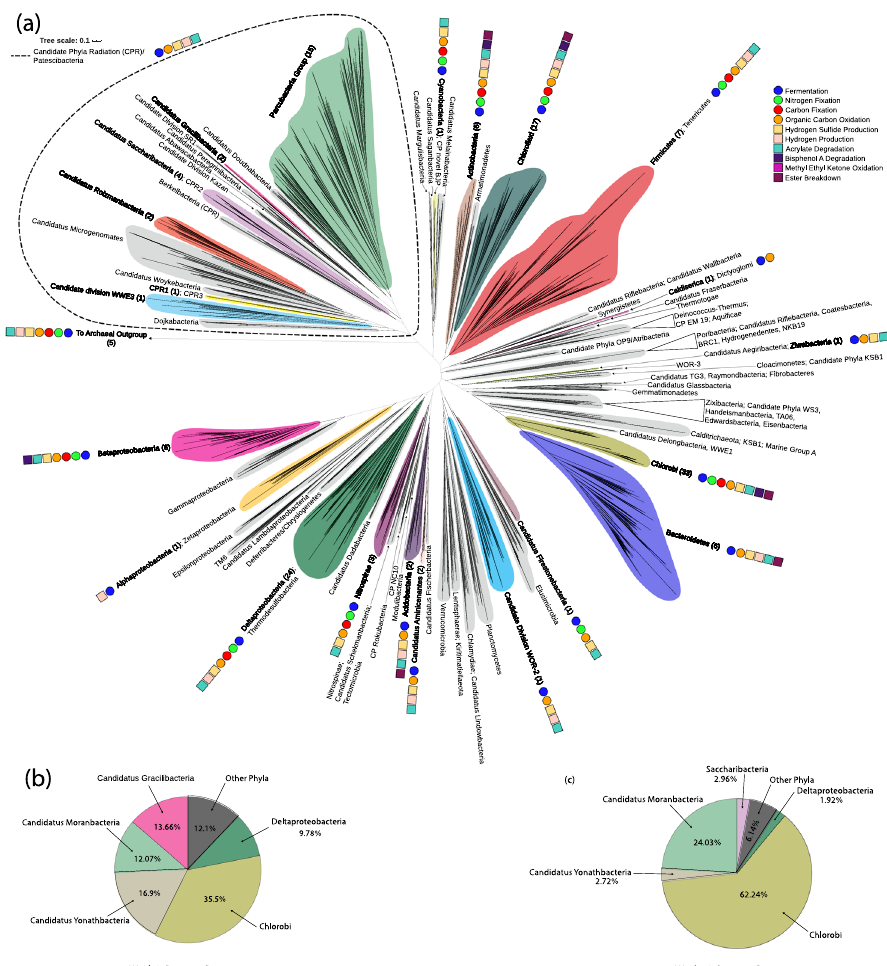
Fig. 6 Phylogenetic and relative abundance analysis of organisms in the polymer composite bio fi lm. a Phylogenetic tree created by alignment of 16 ribosomal proteins of metagenomes curated from two different weeks of sampling. Colored gray are those Phyla and groups of Phyla that did not contain representatives from our set of metagenomes. For Phyla where metagenome sequencing resulted in the presence of genomes within those Phyla, branches are surrounded by colors other than gray and Phyla names are in bold. Indicated with a dashed line are all genomes used to create this tree that fall within the group, Candidate Phyla Radiation. For each Phylum of bacteria and Archaea, colored squares or circles are shown to represent the metabolic capabilities present. b Pie chart describing the percentage of the total coverage values generated from the week 8 genomes associated with each speci fi c Phylum listed. Phyla responsible for the lowest percentages of the total coverage values were grouped into “ Other ” . c Pie chart describing the percentage of the total coverage values generated for the week 18 MAGs associated with each Phylum listed. Phyla responsible for the lowest percentages of the total coverage values were grouped into “ Other ”